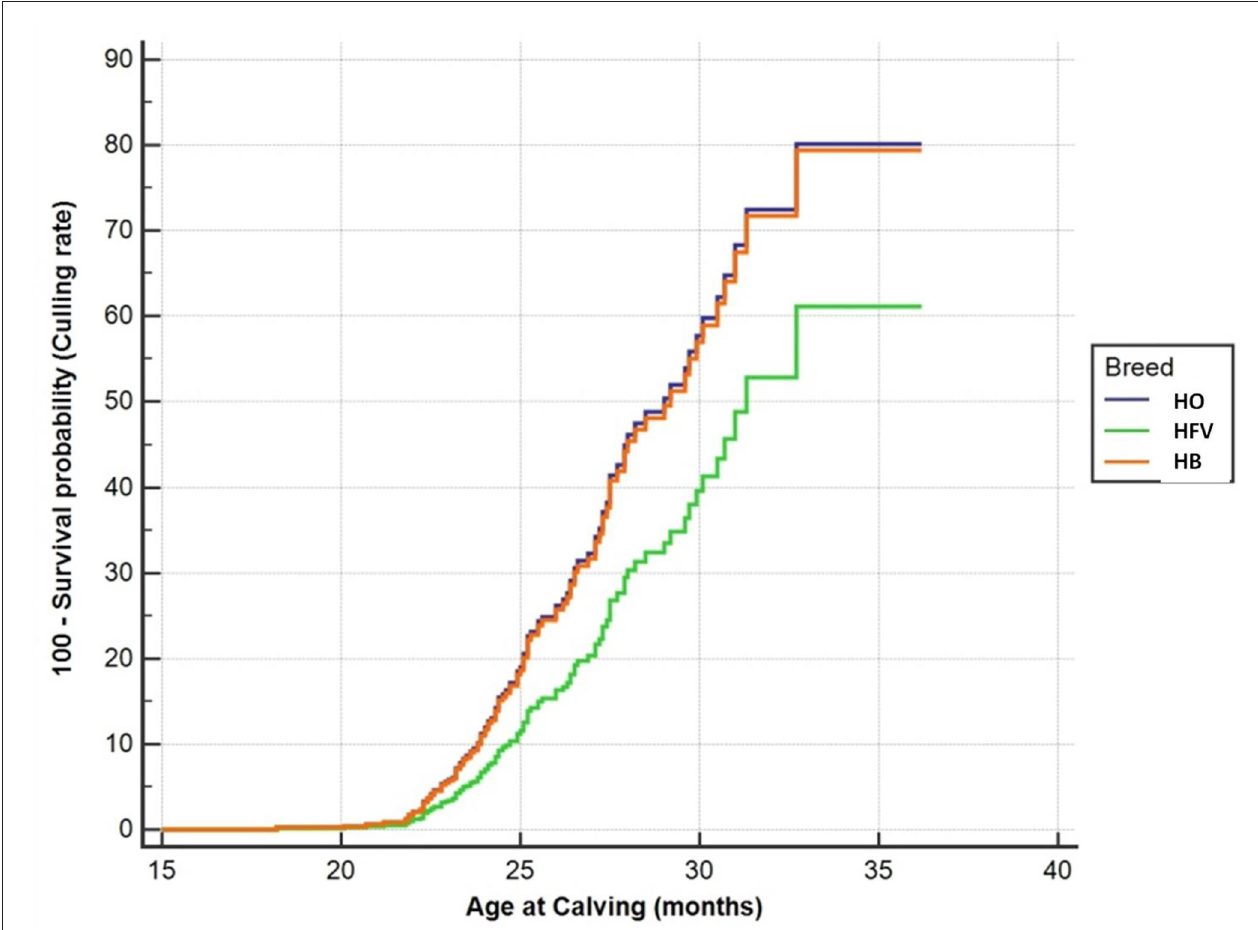
FIGURE 1 | Hazard function for culling rate in primiparous purebred Holsteins (HO) and their crossbred cows. HFV, Holsteins × Fleckvieh; HB, Holstein × Brown Swiss. The time variable was the age at calving.